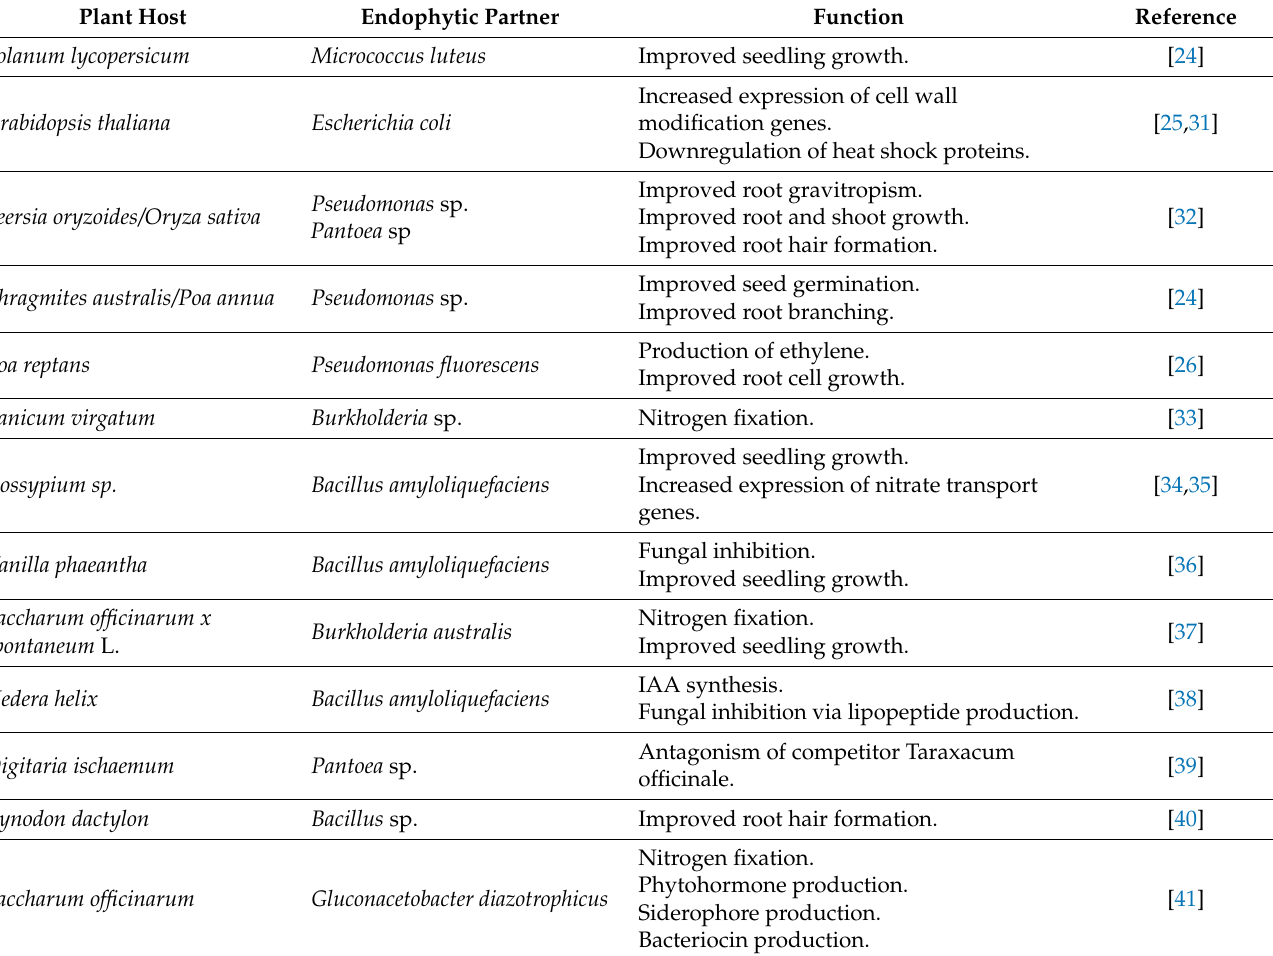
Table 1. A list of plant–endophyte partnerships for which the rhizophagy process has been docu-